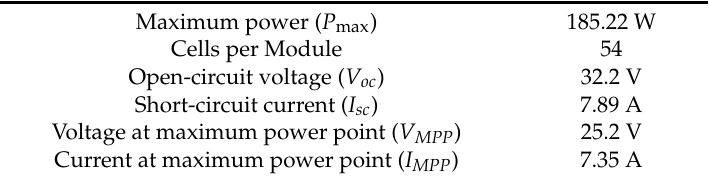
Table 1. The electrical characteristics of Sunperfect Solar CRM185S156P-54 module.